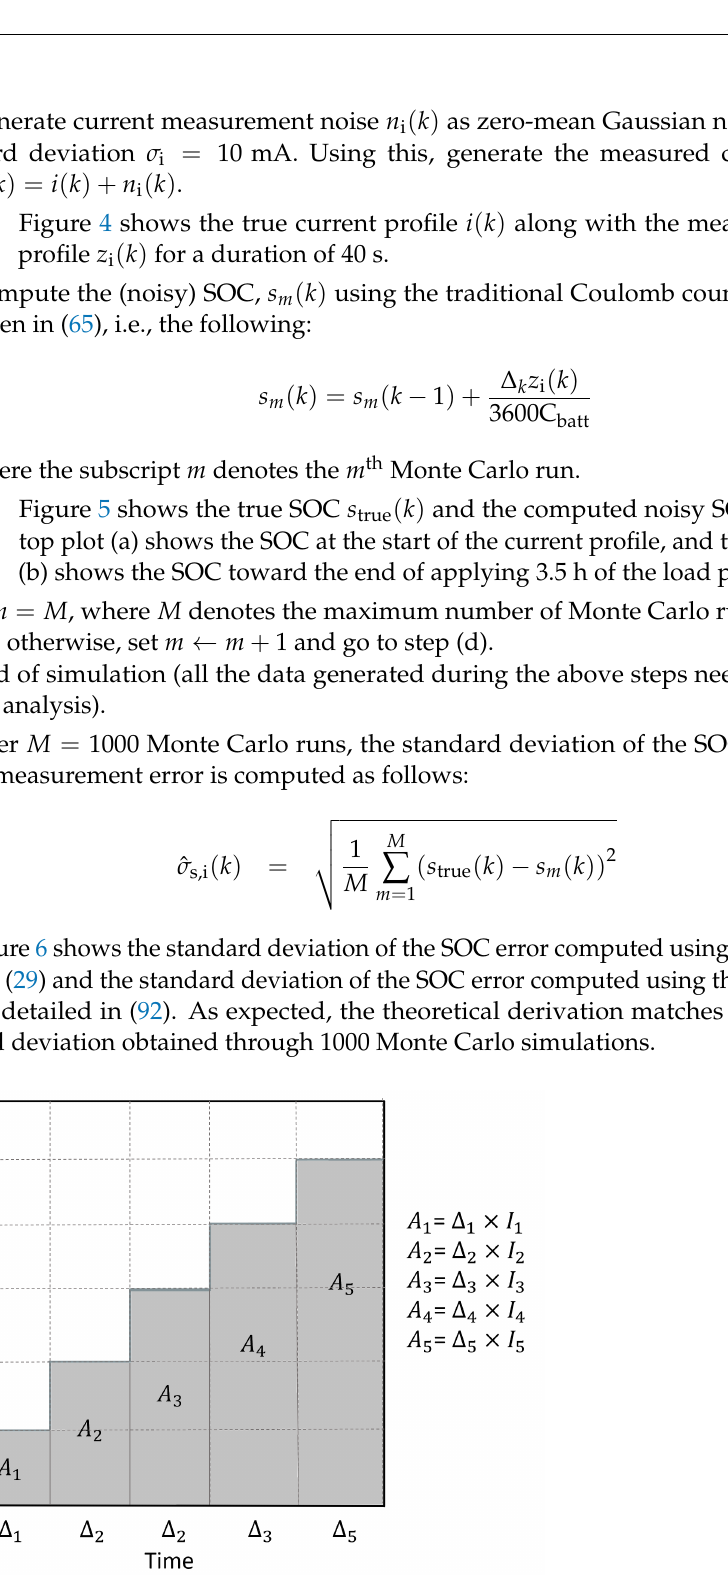
Figure 3. Generic illustration to computing the true amount of Coulombs. Computing true Coulombs is challenging. Here, we assume the true current to take the above pattern; under this assumption, Total Coulombs = A 1 + A 2 + A 3 + A 4 + A 5